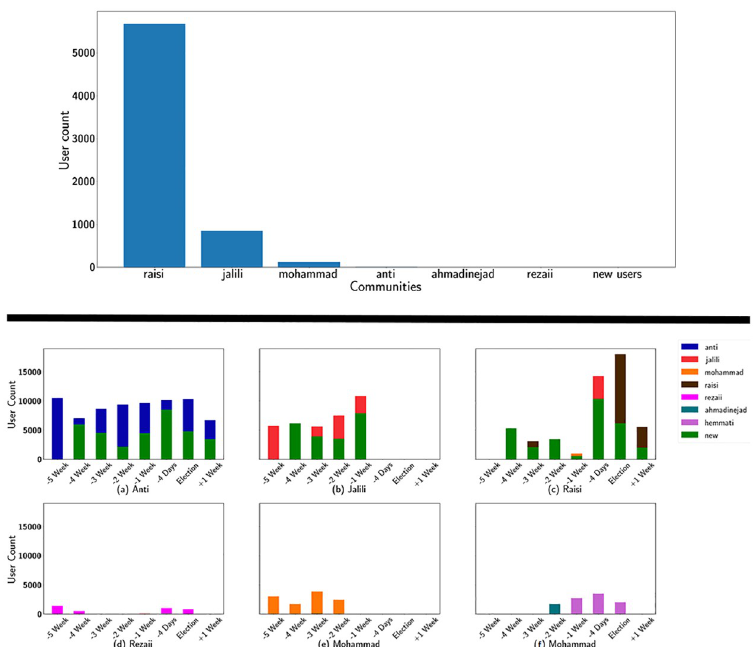
Fig 4. (Above) User distribution of the anti-hemmati community. (Below) The user distribution over the timeline in each community. The colors refer to which community the users belonged to in the previous tick. The communities are: (a) Anti, (b) Jalili, (c) Raisi, (d) Rezaii, (e) Mohammad, (f) Mohammad.